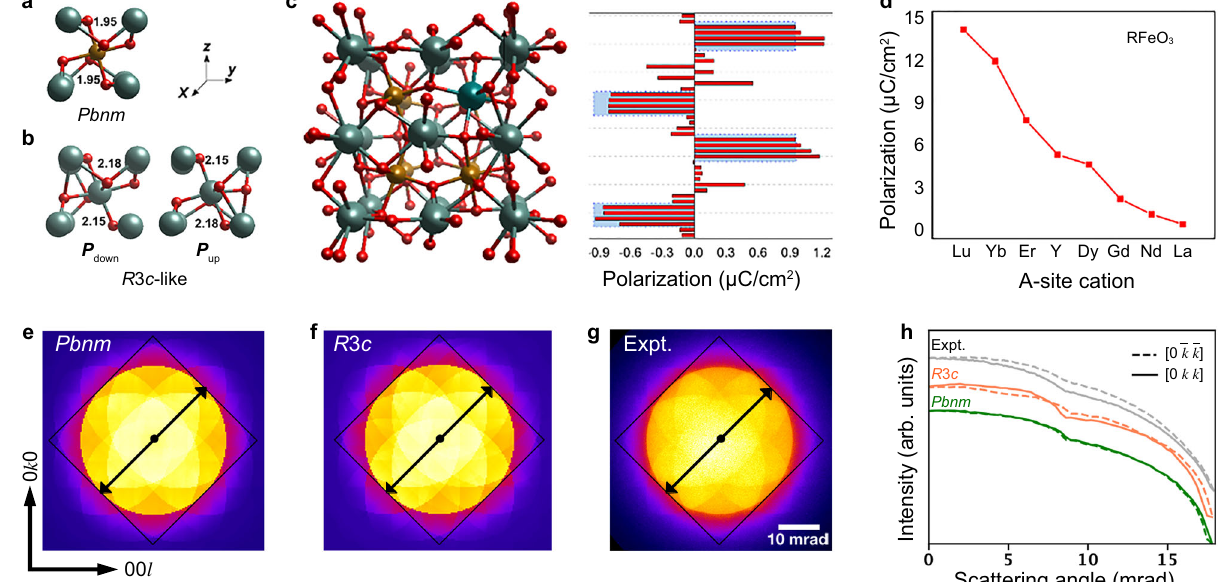
Fig. 4 Crystallographic origin of ferroelectricity in Y-rich YFO. a , b Schematics of centrosymmetric Pbnm ( a ) and non-centrosymmetric R3c -like ( b ) structures. c Crystal structure and layer-resolved polarization for Y-rich YFO. Red columns indicate the atomic contribution to the ferroelectric polarization in Y-rich YFO calculated using the Born charge approximation, while blue columns show layer-resolved contributions to the ferroelectric polarization in stoichiometric YFO. d Ferroelectric polarization for various orthoferrites RFeO 3 that are assumed to be epitaxially grown on SrTiO 3 for all calculations with R/Fe = 1.28. e – g PACBED patterns including the simulated patterns, using the DFT relaxed centrosymmetric Pbnm ( e ) and non-centrosymmetric R3c ( f ) and the experimental result measured from the Y-rich YFO ( α = 1.19) thin fi lm sample ( g ). h Intensity pro fi les integrated across the pattern diagonals from PACBED patterns along the black arrows shown in e – g The symmetry calculation suggests the origin of the ferroelec- given in Fig. 4c. Both Y Fe defects and epitaxial strain promote the tricity lies in the structural distortion around the Y Fe sites, where formation of the R 3 c regions within the Pbnm YFO structure the Pbnm structure (Fig. 4a) is locally distorted into a region with (Supplementary Note 7). R 3 c -like symmetry (Fig. 4b). In YFO, the changes in bonding of oxygen atoms adjacent to Y Fe break the inversion symmetry, generating a net local dipole moment (Fig. 4b), which further polarizes the surrounding stoichiometric regions, producing a spontaneous polarization. The layer-resolved polarization for Y- rich YFO, calculated using the Born charge approximation, is